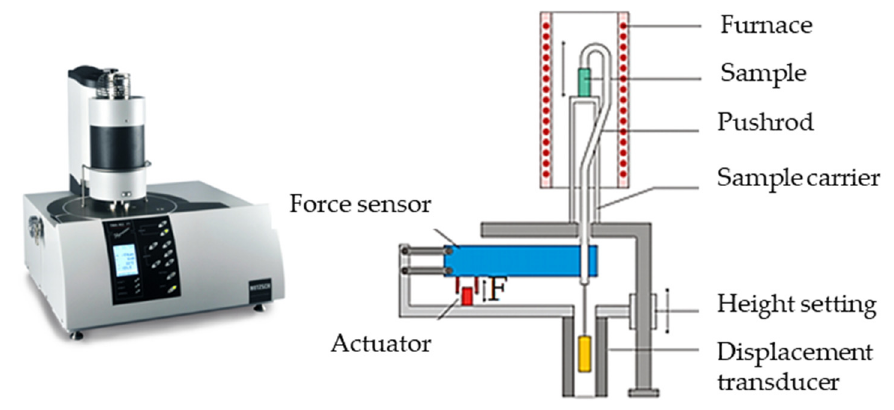
Figure 4. NETZSCH TMA 402 F1 Hyperion ® device and its elements used for the measurements of thermal expansion coefficient.